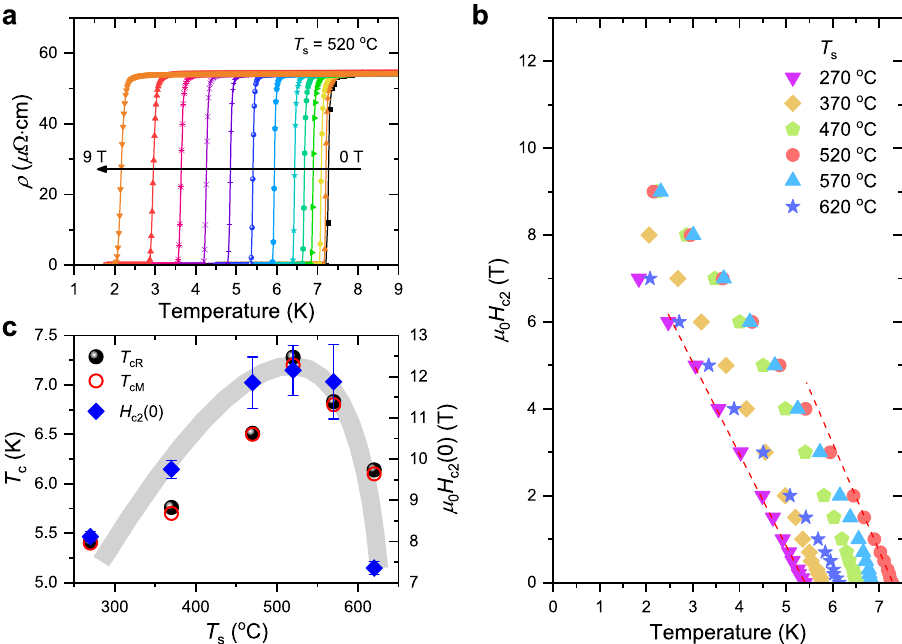
Fig. 2 Upper critical fi elds and SC transition temperatures of HEA SC thin fi lms with respect to the growth temperature. a Representative ρ ( T ) curves under various magnetic fi elds ranging from 0 to 9 T for the HEA SC thin fi lm fabricated at the optimal T s = 520 °C, where the direction of the applied magnetic fi eld was perpendicular to the ab plane of the fi lms. b Upper critical fi eld ( μ 0 H c2 ) as a function of the temperature for the HEA SC thin fi lms, determined by 50% of the SC transition from the ρ n at each magnetic fi eld. Red dashed lines for T s = 270 and 520 °C indicate representative linear fi ts for the estimation of d H c2 /d T near T c . c T c and μ 0 H c2 at zero Kelvin, μ 0 H c2 (0), with respect to the substrate temperature T s . Here, T cR and T cM were determined by the 50% transition of ρ n and the irreversible points of the ZFC and FC M ( T ) curves, respectively, and the μ 0 H c2 (0) was estimated using the Werthamer – Helfand – Hohenberg model. T c and μ 0 H c2 (0) exhibit a similar behavior with respect to T s , implying that the high T c of HEA SC thin fi lms leads to a large μ 0 H c2 (0). The error bars on the μ 0 H c2 (0) re fl ect the uncertainties in the linear fi tting of d H c2 /d T around T c . Half-transparent shades are guides to the eyes.